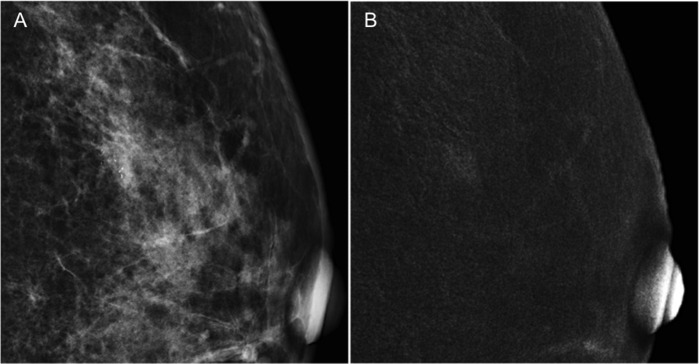
A 57-year-old woman referred from a local hospital due to suspicious malignant microcalcifications (BI-RADS 4) on biennial mammographic screening.(A) The low energy conventional mammogram on craniocaudal view showed a cluster of pleomorphic microcalcifications in the lower outer quadrant of left breast; however the sonographic evaluation revealed negative of associate mass. (B) CESM revealed a 0.7-cm irregular nodular enhancement over the associated microcalcifications. Stereotactic core needle biopsy diagnosed it to carcinoma in situ, however surgery subsequently proved it to be invasive ductal cancer.